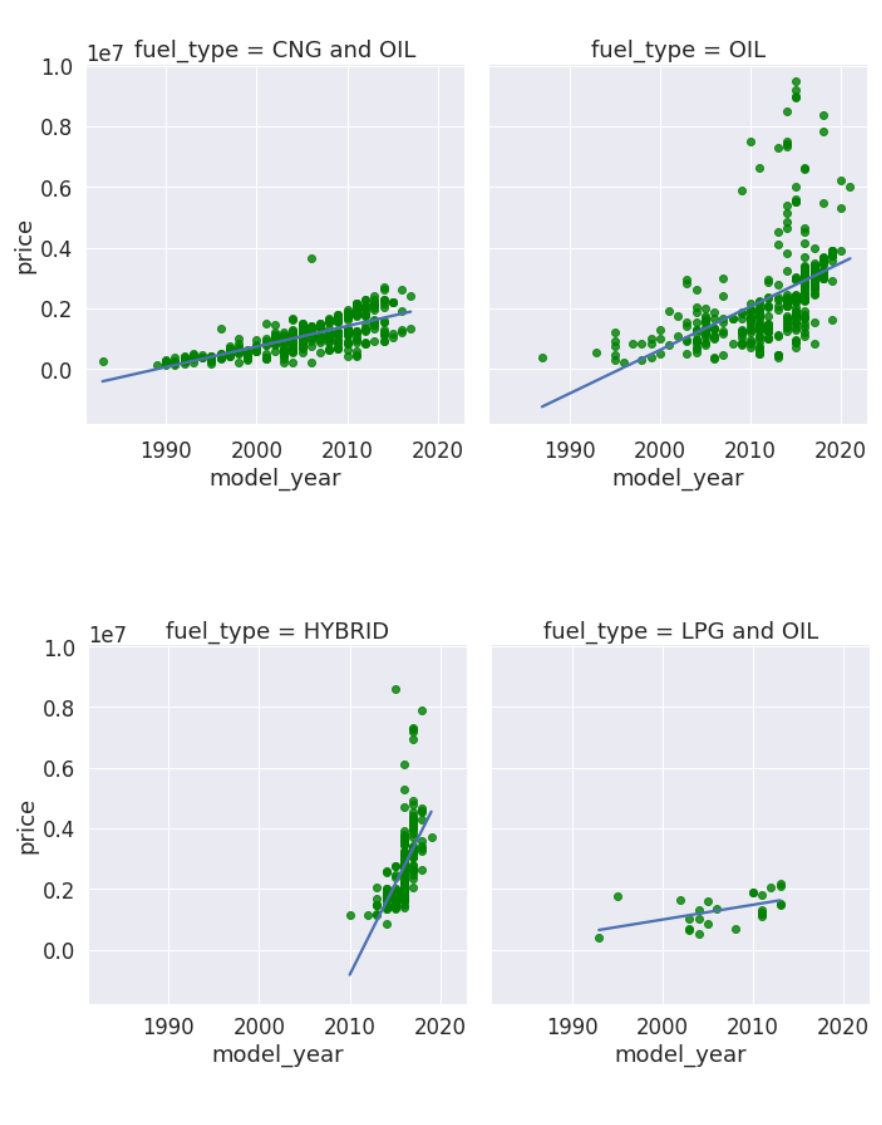
Figure 5. Linear model plot for model_year and price